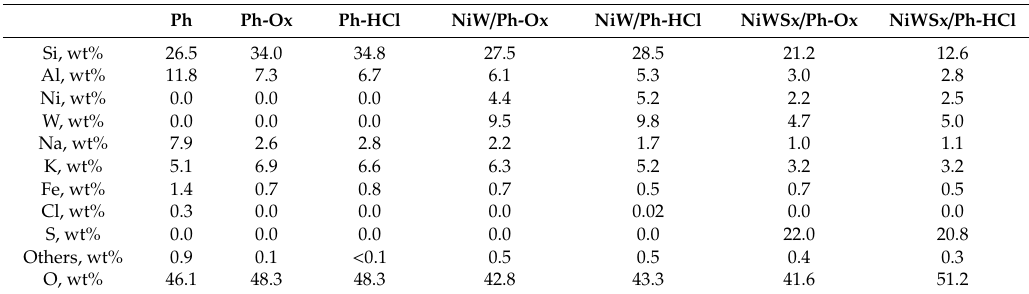
and catalysts. Hg porosimetry of Ph, Ph-Ox, Ph-HCl, NiW / Ph-Ox, and NiW / Ph-HCl. The elemental